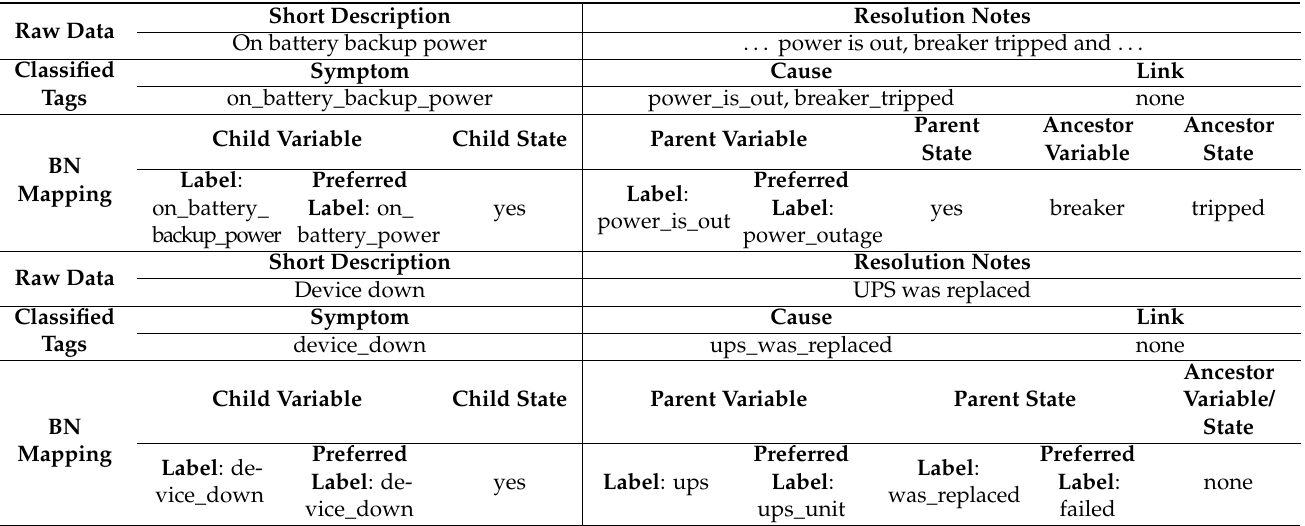
Table 6. Two examples of raw data rows and their corresponding structured output.